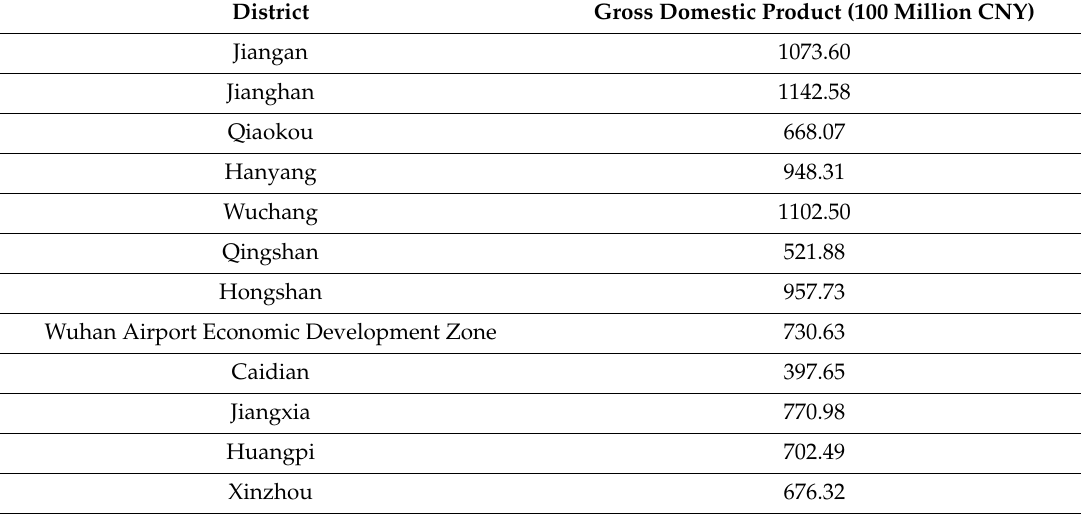
Table A1. Gross domestic product by district in Wuhan (2017).